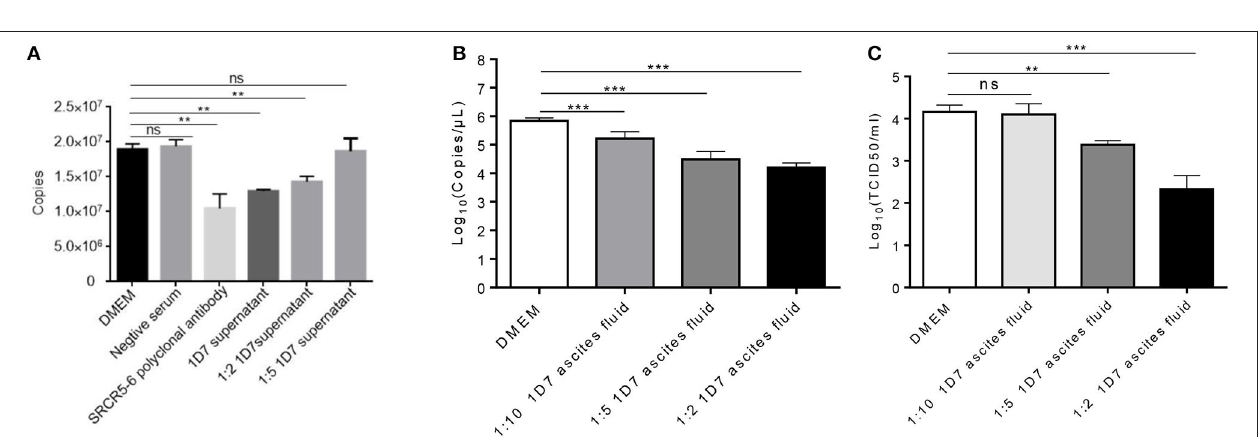
FIGURE 4 | Role of CD163 antibody 1D7 in blocking PRRSV infection. (A) Porcine AMs were pre-treated with different doses of 1D7 supernatant before PRRSV infection for 2h at 37 ◦ C. The cells were then infected with HP-PRRSV HuN4, and incubated for 2h at 37 ◦ C. The total RNA of AMs were extracted, and RT-qPCR was used to detect the transcription level of ORF7 mRNA. (B) Porcine AMs were pre-treated with different doses of 1D7 ascites fluid for 2h at 37 ◦ C followed by HuN4-EGFP infection at a MOI of 0.005 for 48h at 37 ◦ C; the cell supernatants were then collected, and the total RNA of supernatants were extracted according to M&M. RT-qPCR was used to identify viral replication. (C) TCID 50 was also used to identify viral replication. Error bar: mean ± SEM; ** p ≤ 0.01; *** p ≤